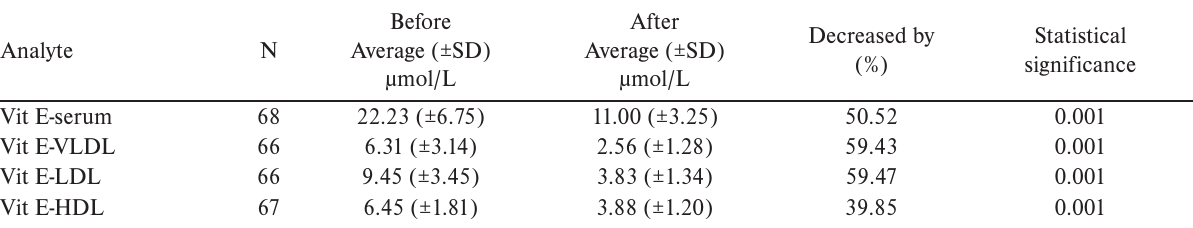
Table 2. Levels of vitamin E in serum and lipoprotein fractions before and after RH treatment.